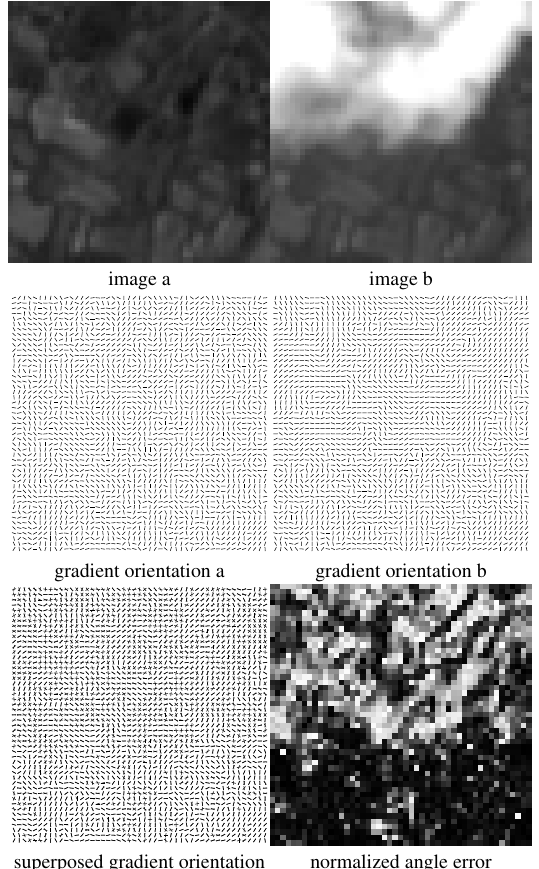
Figure 1. First row: Two images, a and b, to be compared (from Sentinel-2 constellation). Second row: The image gradient orientation field of both images. Third row left: the image gradient orientation fields of both images superposed; one can see how these orientations roughly agree in the visible zone while mainly differing where a cloud is present. Third row right: normalized gradient orientation error between the two images; black corresponds to zero error (same gradient orientation in both images) while white corresponds to the worst error (the gradient orientations have opposite